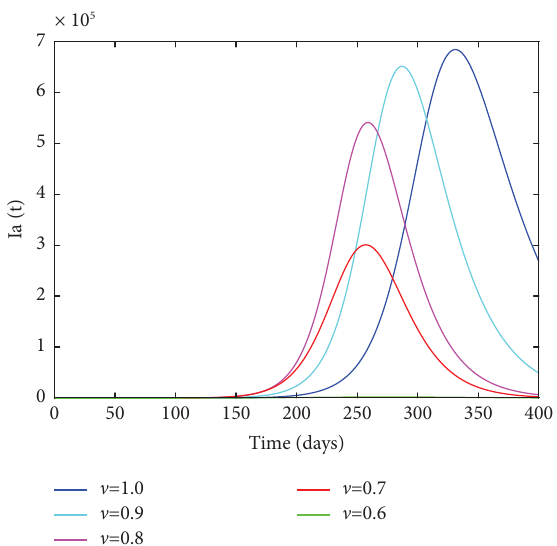
Figure 4: Behaviour of the asymptomatic individuals at diferent values of v .